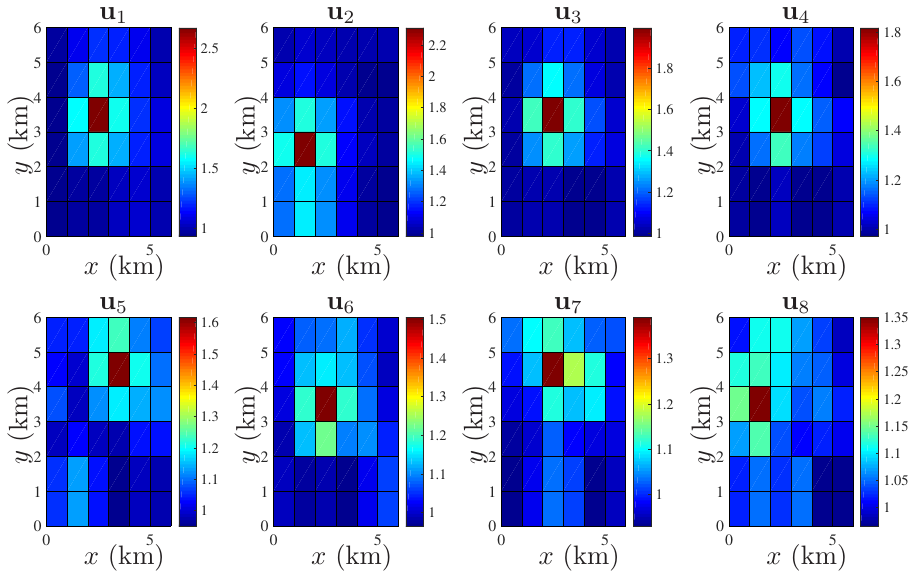
Figure 4. Spatio-temporal evolution of u t in a 6 × 6 square km area; spatial resolution: 1 × 1 square km; time varying H t for t = 1, . . . ,8; strength of spatial correlation: θ =